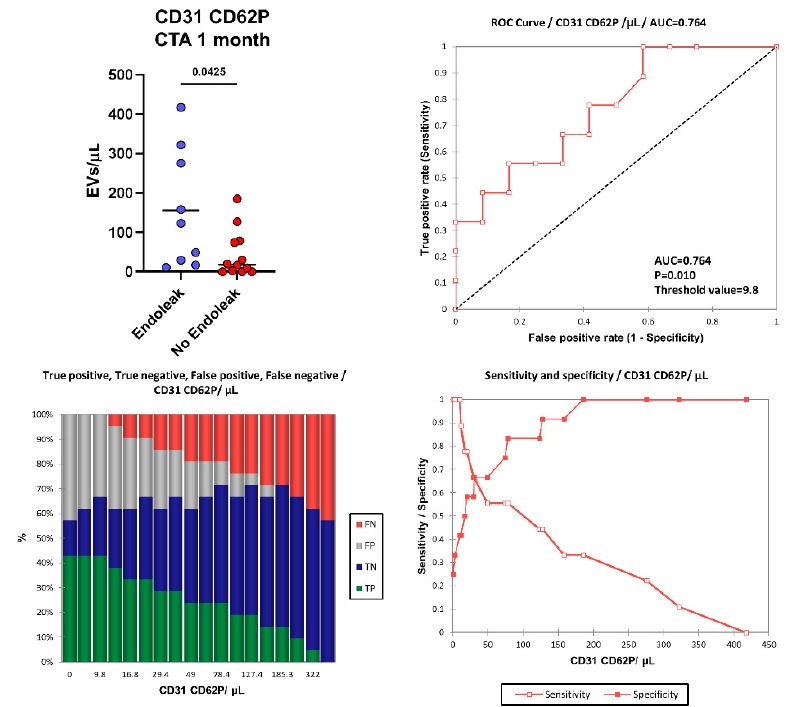
Figure 6. Number of CD31+ CD62P+ EVs were compared between the Endoleak and No Endoleak cohorts of patients after 1 month following EVAR intervention. Horizontal lines represent mean values. Statistical significance was calculated using non-parametric Mann–Whitney U-tests (two- tailed). Receiver operating characteristic (ROC) curve and performance plots, showing the reliability of CD31+ CD62P+ EVs used as early biomarkers to identify patients undergoing post-EVAR com- plications (i.e., endoleaks). TP = True Positive (green bar); TN = True Negative (blue bar); FP = False Positive (grey bar); FN = False negative (red bar). The threshold value of 9.8 CD31+ CD62P+ EVs/ μ L allowed us to obtain a sensitivity of 1.000, a specificity of 0.417, a PPV of 0.563, and an NPV of 1.000.